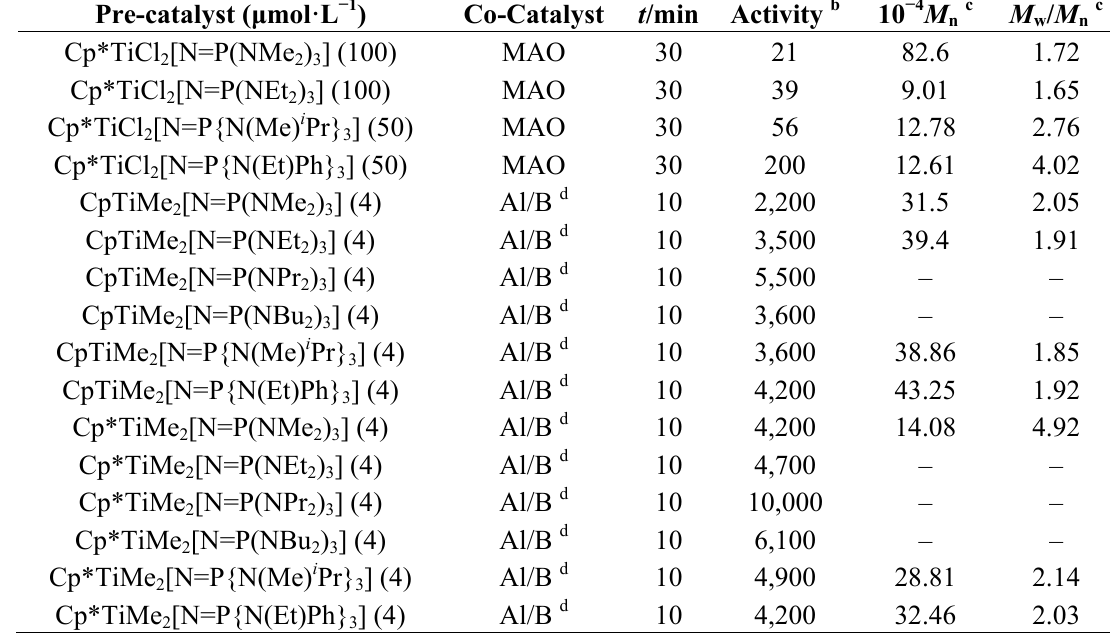
Table 6. Ethylene polymerization by Cp'TiX reprinted with permission form [186]. Copyright 2011